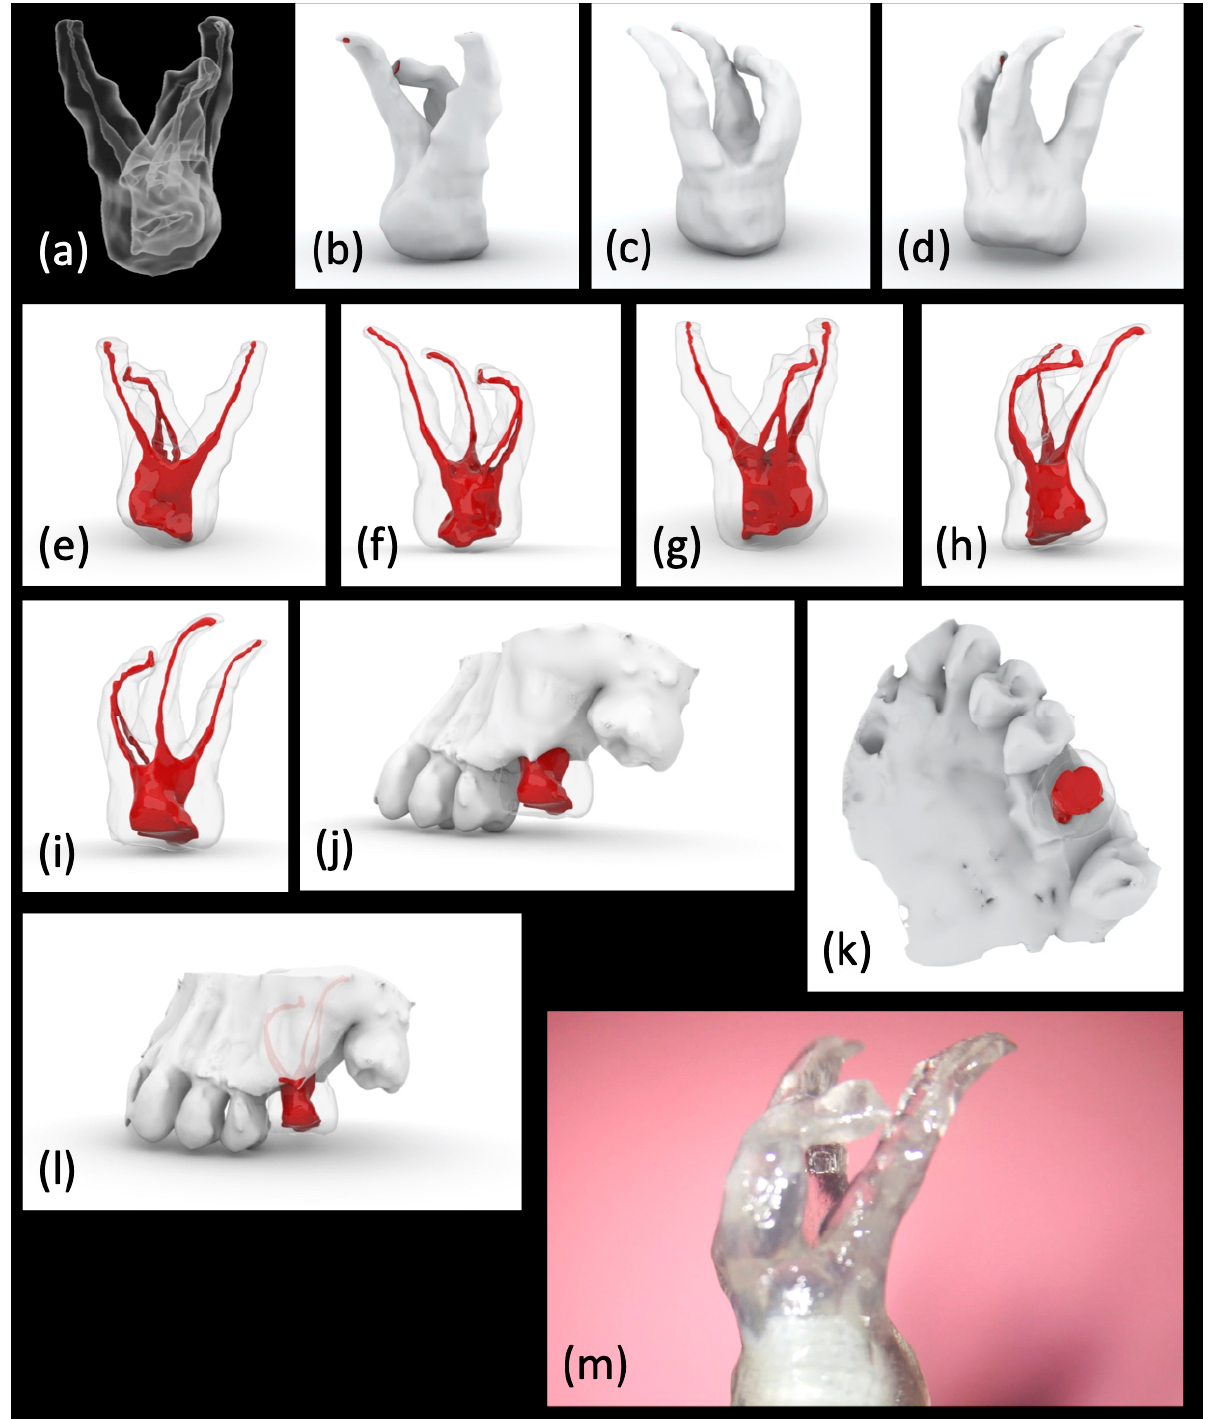
Figure 7. ( a–l ) CBCT data were uploaded to an STL software and ( m ) a transparent plastic model was three-dimensionally printed.